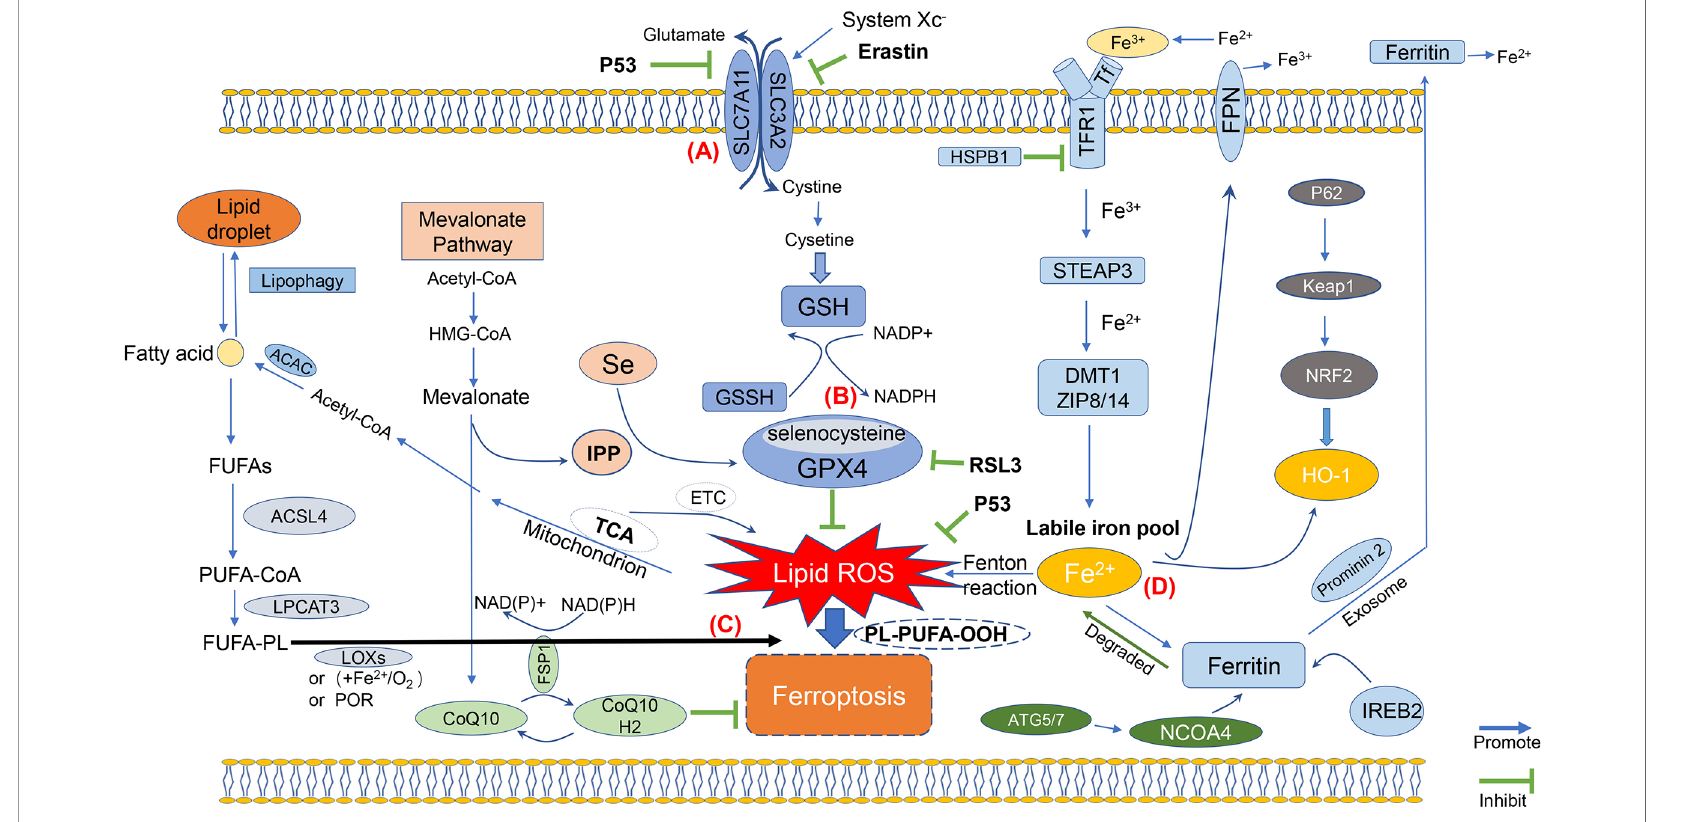
FIGURE 1 | Molecular mechanisms of ferroptosis. The fi gure shows the molecular mechanisms of ferroptosis, which can be simply divided into four categories. (A) The fi rst one is regulated by the system Xc; (B) Then, the second molecular regulatory mechanism is mainly the GSH/GPX4 pathway, which is currently one of the most important antioxidant systems; (C) Third, the molecular mechanisms of iron metabolism, such as IREB2 and Prominin 2, are related to ferritin metabolism, and both Ferroportin and TFR1 such as ACSL4 and LPCAT3, regulatory pathways have an impact on iron transport; (D) The fourth category is the lipid metabolism-related pathway, such as ACSL4, LPCAT3, which have an impact on lipid peroxidation and